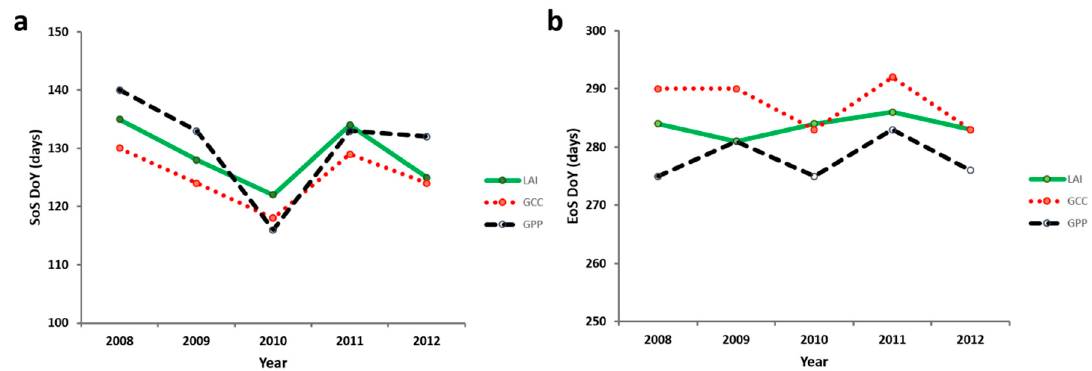
Figure 7. Interannual variation of the ( a ) start of the growing season (SoS), and ( b ) end of season (EoS) estimated from the CGLS LAI V2, PhenoCam GCC and FLUXNET GPP with the threshold method (percentile 30 for the timing of SoS, and percentile 40 for the timing of EoS) over the Harvard Forest (Latitude 42.54º, Longitude –72.17º).